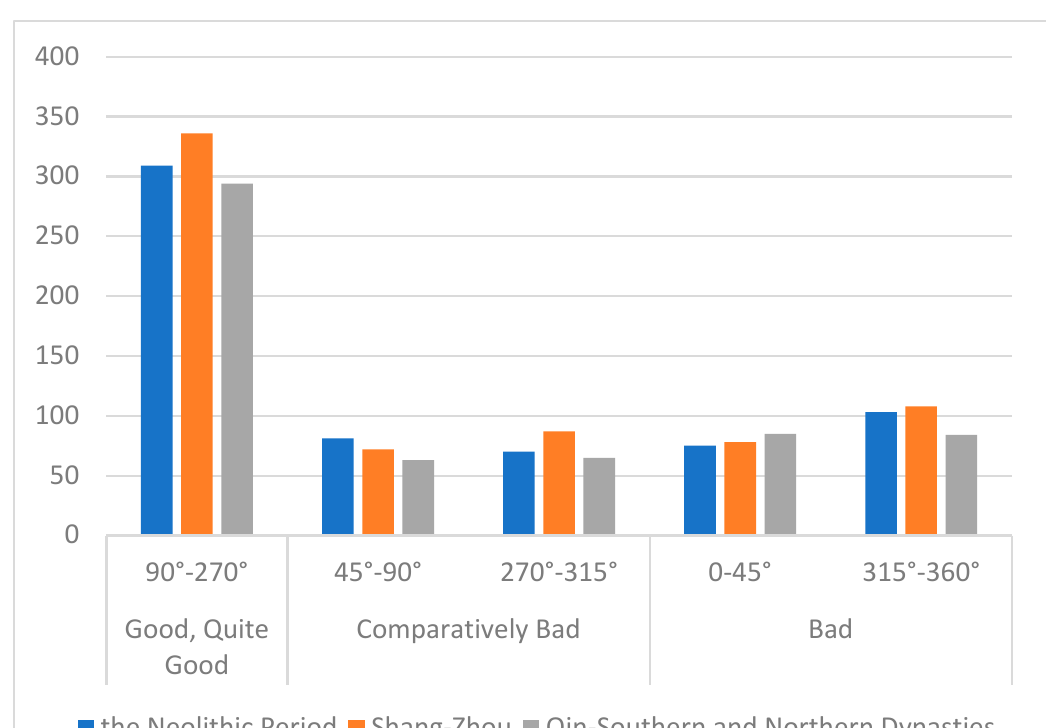
Figure 11. Aspect statistics of the distribution of settlements in different periods.